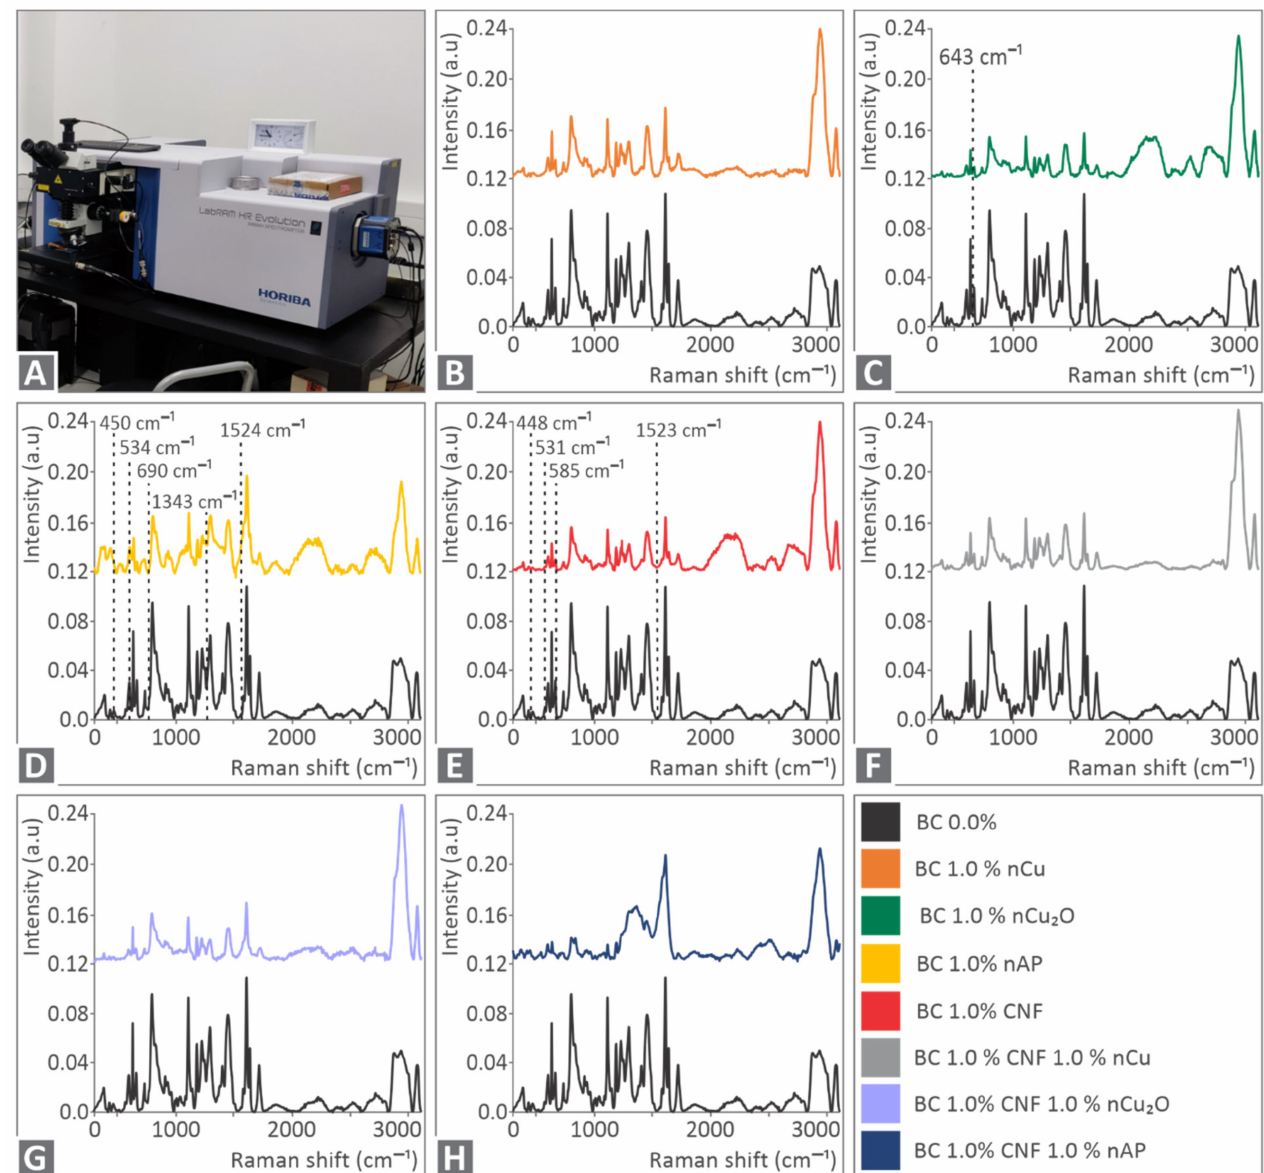
Figure 3. Raman Spectroscopy Analysis. In the first picture, the Raman Microscope used is depicted, followed by the related Raman Spectra from the different samples. Lastly, the color code for the different samples is described: ( A ) Raman spectra device, ( B ) spectra of BC 1.0 wt.% nCu vs BC, ( C ) spectra of BC 1.0 wt.% nCu 2 O vs BC, ( D ) spectra of BC 1.0 wt.% nAP vs BC, ( E ) spectra of BC 1.0 wt.% CNF vs BC, ( F ) spectra of BC 1.0 wt.% CNF 1.0 wt.% nCu vs BC, ( G ) spectra of BC 1.0 wt.% CNF 1.0 wt.% nCu 2 O vs BC, ( H ) spectra of BC 1.0 wt.% CNF 1.0 wt.% nAP vs